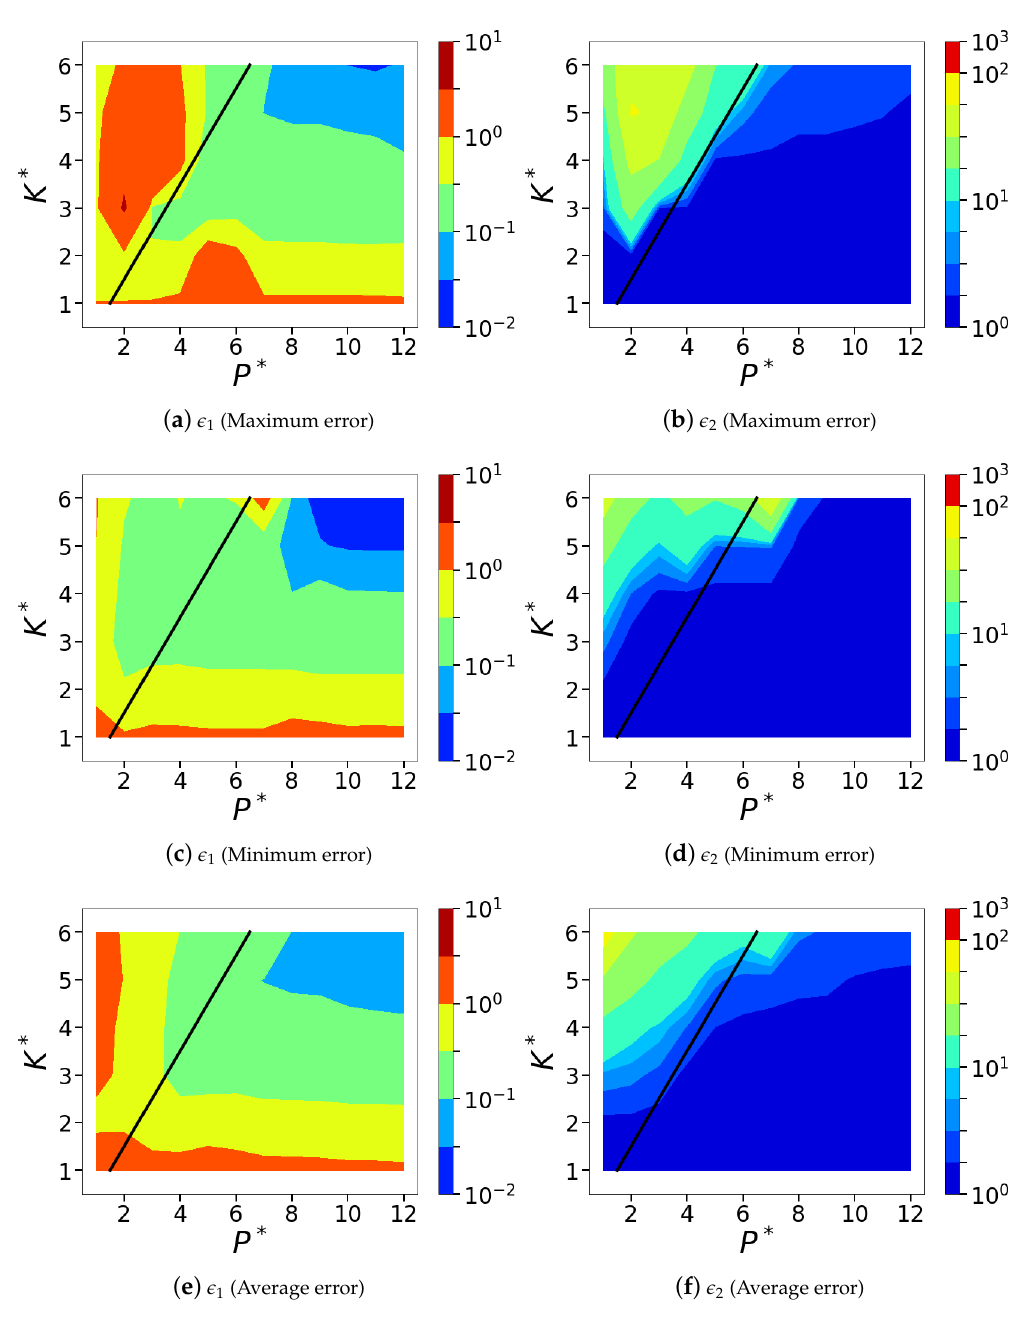
Figure 12. Isocontours of the normalized mean squared POD-based sparse reconstruction errors ( l 2 norm) corresponding to the sensor placement with maximum and minimum errors from the chosen ensemble of random sensor arrangements. The average error across the entire ensemble of ten random sensor placements is also shown. Subfigures ( a , c , e ) show the normalized absolute error metric, (cid:101) 1 and subfigures ( b , d , f ) show the normalized relative error metric, (cid:101) 2 . Top row corresponds to the case with maximum error; middle row shows the case with minimum error and the bottom row shows the averaged error across different